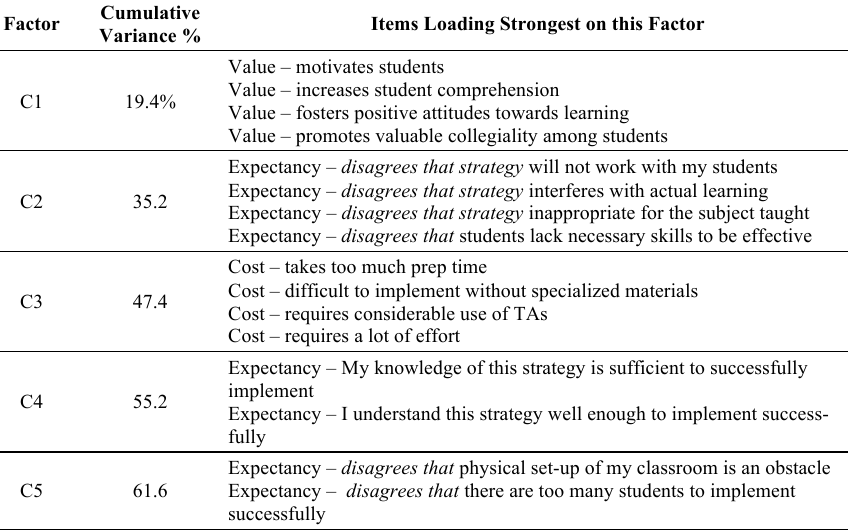
Table 7. Student-to-student discussions, factor